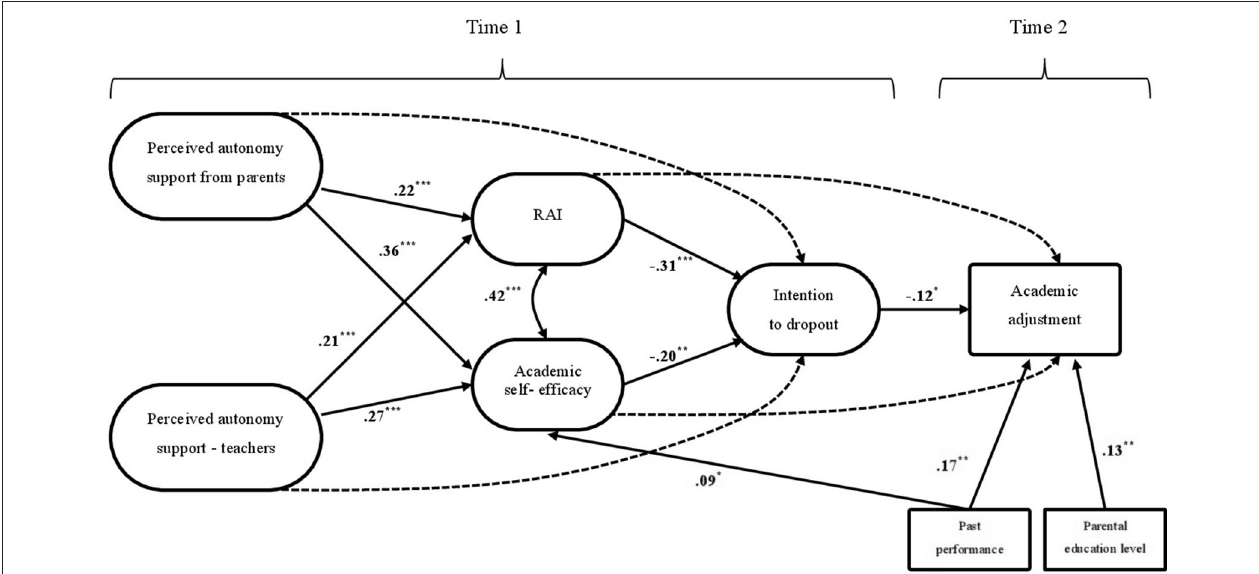
FIGURE 1 | Standardized path coefficients for structural equation model of hypothesized relations among model constructs. RAI, Relative Autonomy Index; dashed lines indicate paths that were not statistically significant ( p > 0.05) in the SEM analysis. Direct effects of past performance and parental education level on all variables in the model estimated but not depicted in diagram: past performance → perceived autonomy support (parents) ( β = 0.068, p = 0.192); past performance → perceived autonomy support (teachers) ( β = 0.056, p = 0.296); past performance → RAI ( β = 0.072, p = 0.160); past performance → intention to dropout ( β = 0.023, p = 0.652); parental education level → perceived autonomy support (parents) ( β = 0.089, p = 0.086); parental education level → perceived autonomy support (teachers) ( β = 0.011, p = 0.838); parental education level → RAI ( β = − 0.055, p = 0.284); parental education level → academic self-efficacy ( β = − 0.091, p = 0.056); parental education level → intention to dropout ( β = − 0.053, p = 0.297). *** p < 0.001; ** p < 0.01; * p < 0.05.